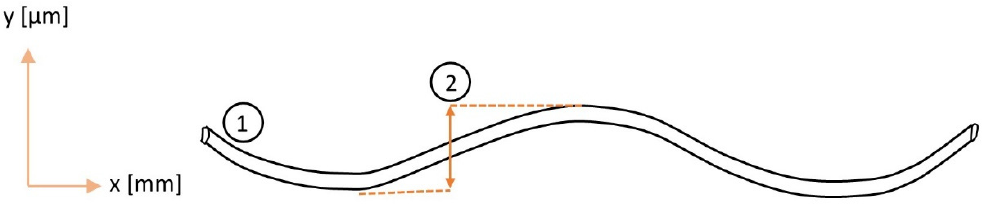
Figure 5. Model of fresh structured wire; 1: wire; 2: effective wire diameter.